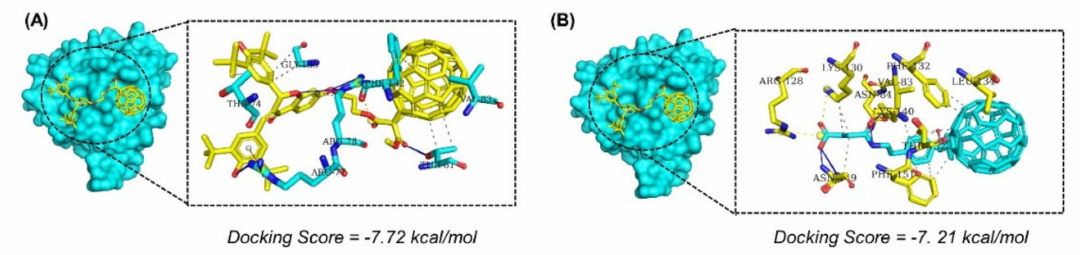
Figure 2. ( A ) Binding mode of the best hit 1. The best hit is shown as yellow while the interacting amino acids are shown in cyan color. ( B ) Binding mode of the best hit 2. The best hit is shown as yellow while the interacting amino acids are shown in cyan color.